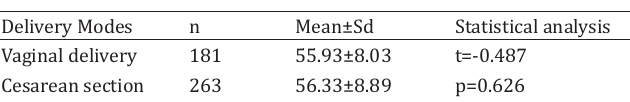
Comparison of Total Score Averages of Puerperants obtained in BIMF by